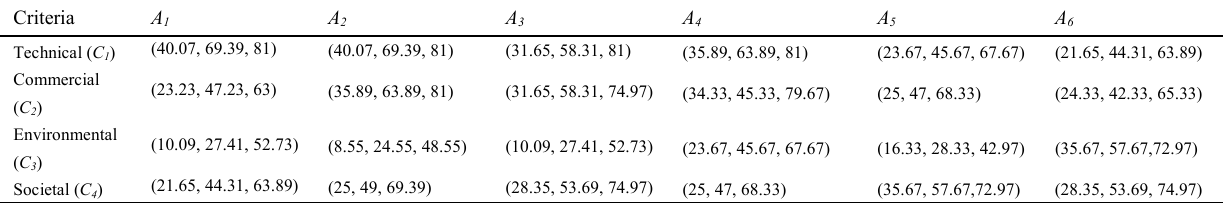
Table 8. The performance index of recoverable end-of-life product alternatives and their